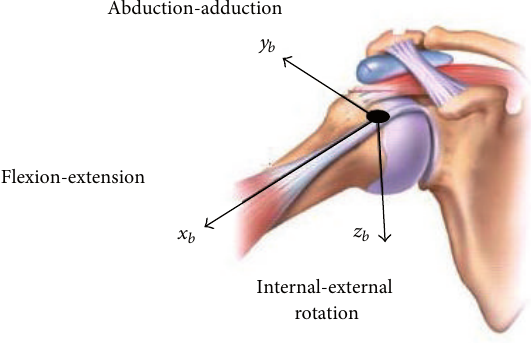
Figure 1: Shoulder region with rotation